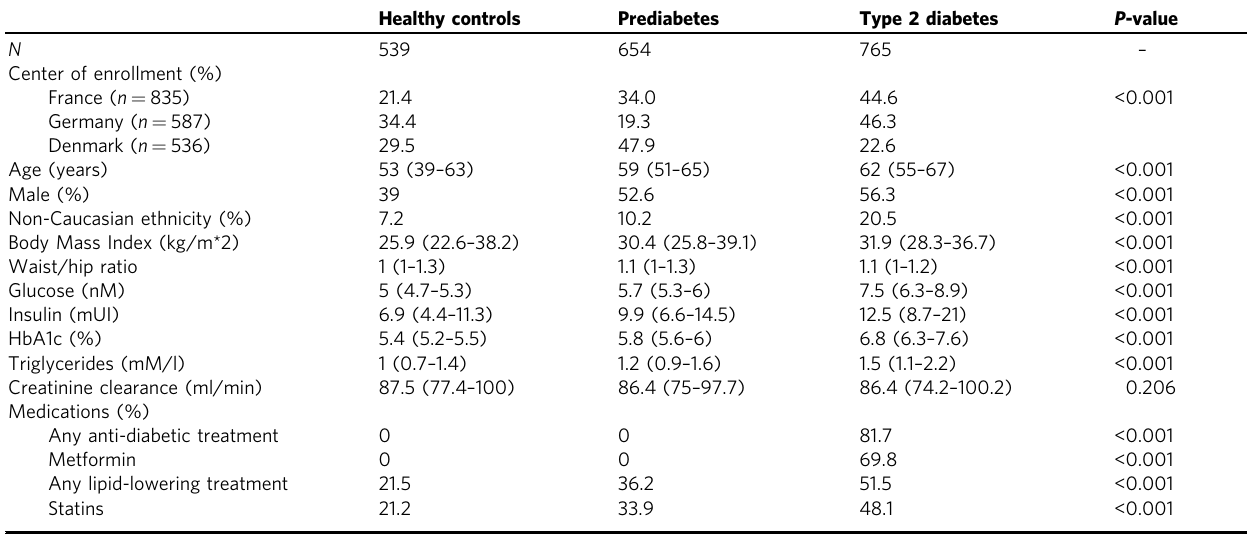
Table 1 Clinical and biochemical features of the MetaCardis